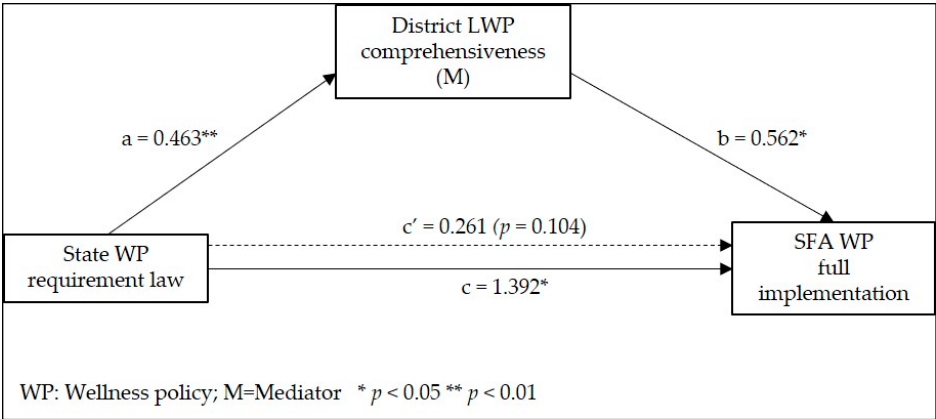
Figure 1. Mediation analysis path diagram.